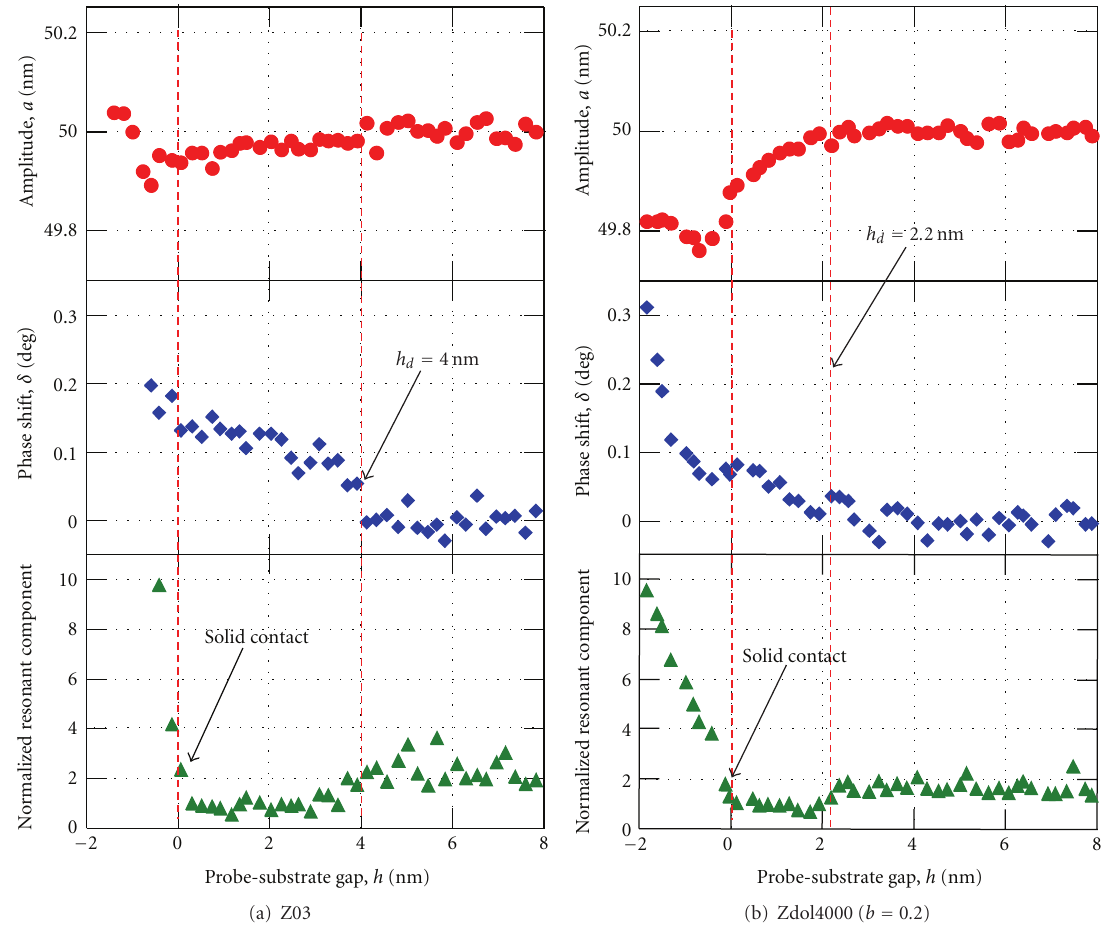
Figure 10: Probe amplitude, phase shift, and normalized resonant component measured for (a) Z03 and (b) Zdol4000 with a bonding ratio of 0.2 in the approaching process